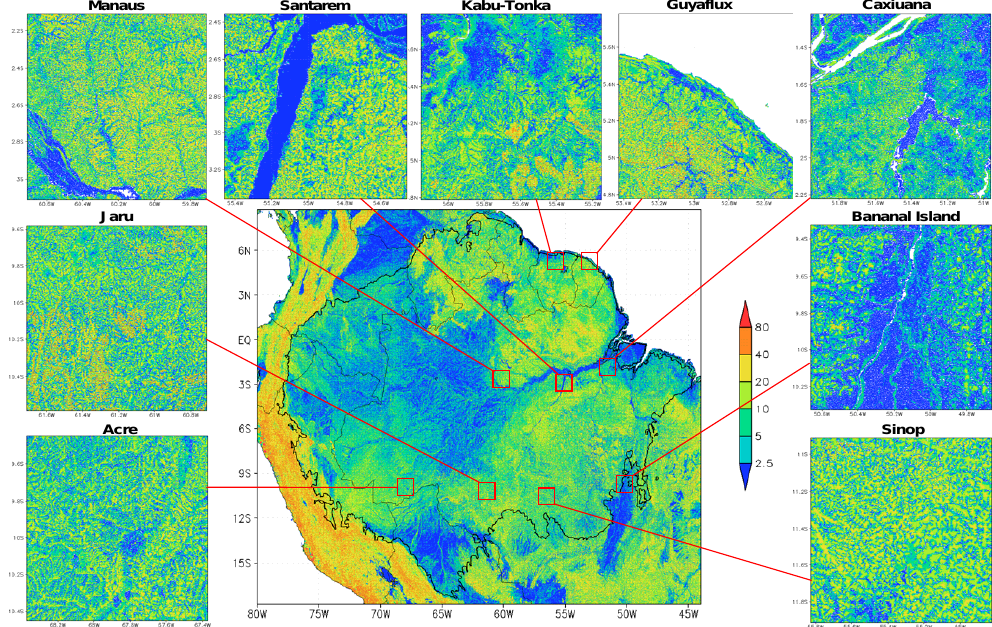
Fig. 13. Spatial details in the CLM-forced WTD simulation (m) in Amazonia and around the nine sites with independent ET estimates (white cells = WTD at land surface).